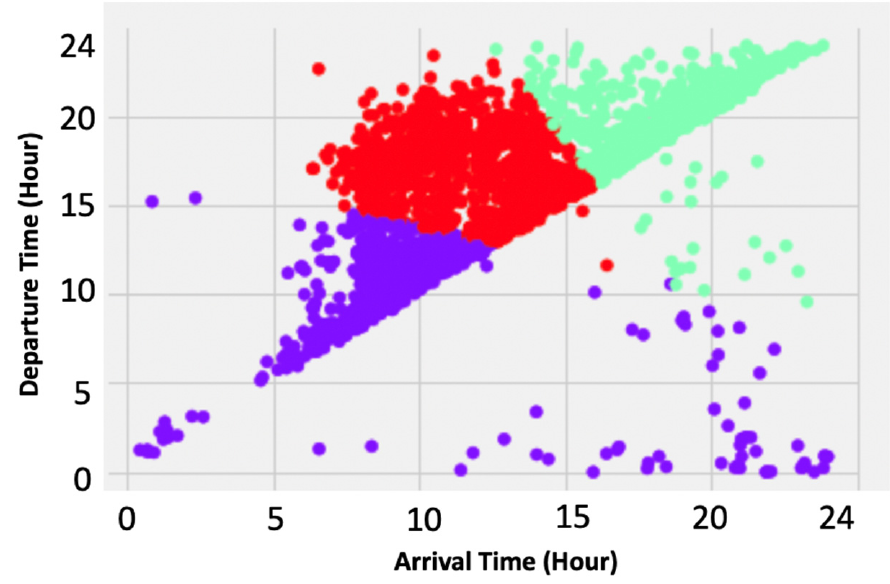
Figure 6. Cluster visualization for K-means.